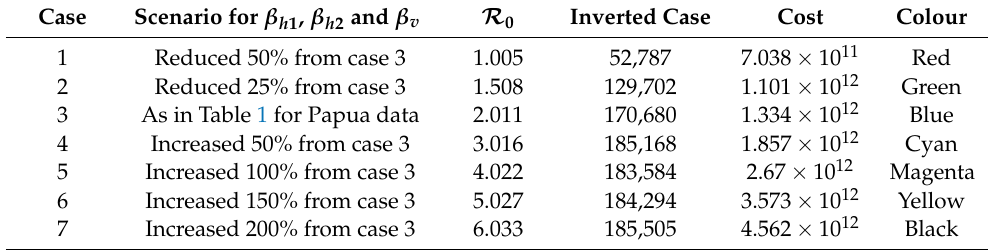
Figure 13. Time series dynamics for; humans ( a – h ), mosquitoes ( i , j ), and controls ( k , l ), but different initial R 0 when no control applied. The color in the legend are explained in Table 5. Table 5. Numerical results for various initial value of the non-controlled basic reproduction